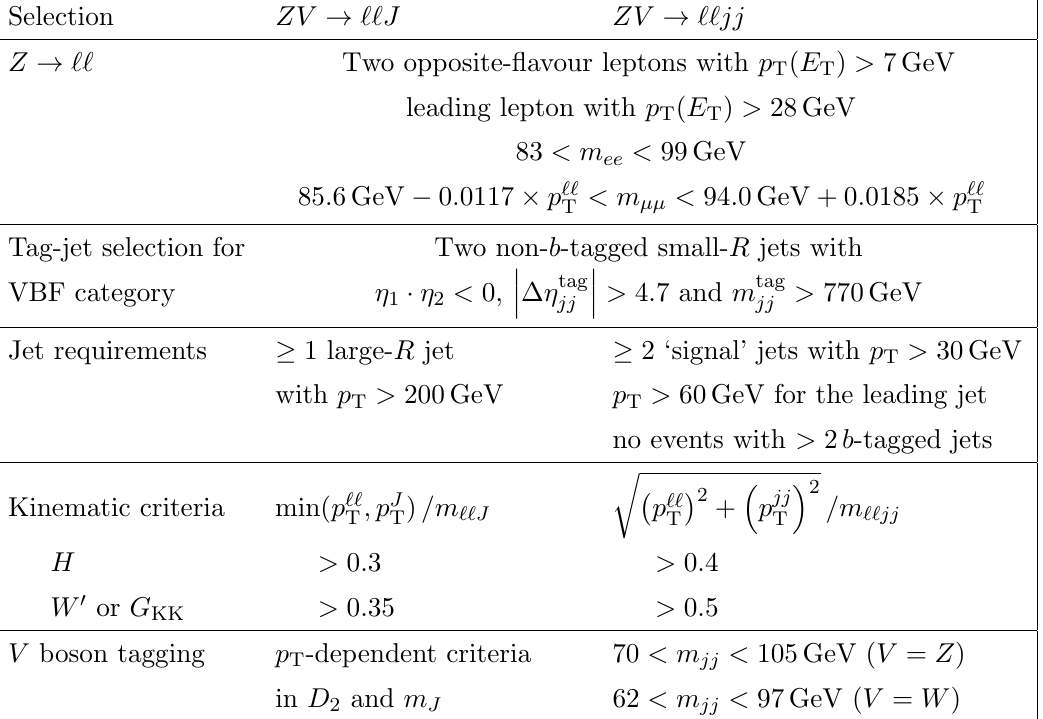
Table 1 . Summary of the X